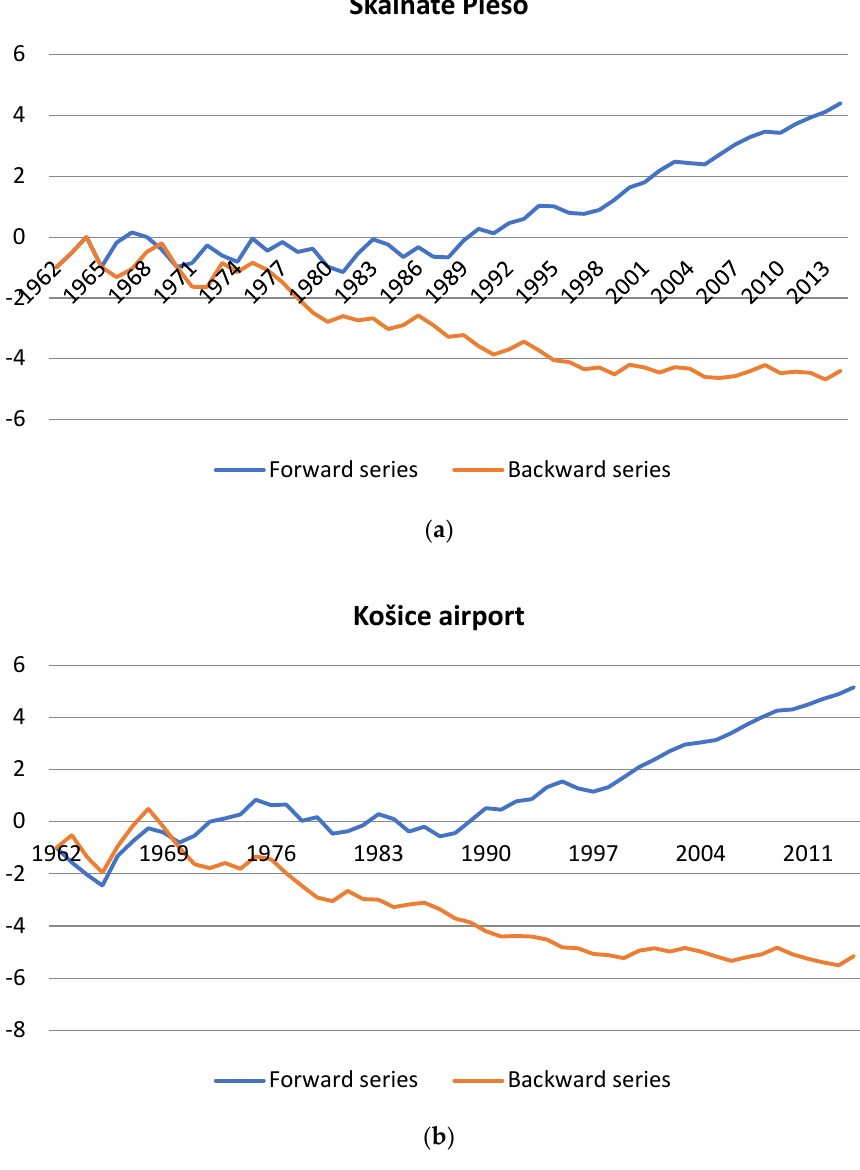
Figure 8. Forward and backward series of the SQMK test on the temperature data series.